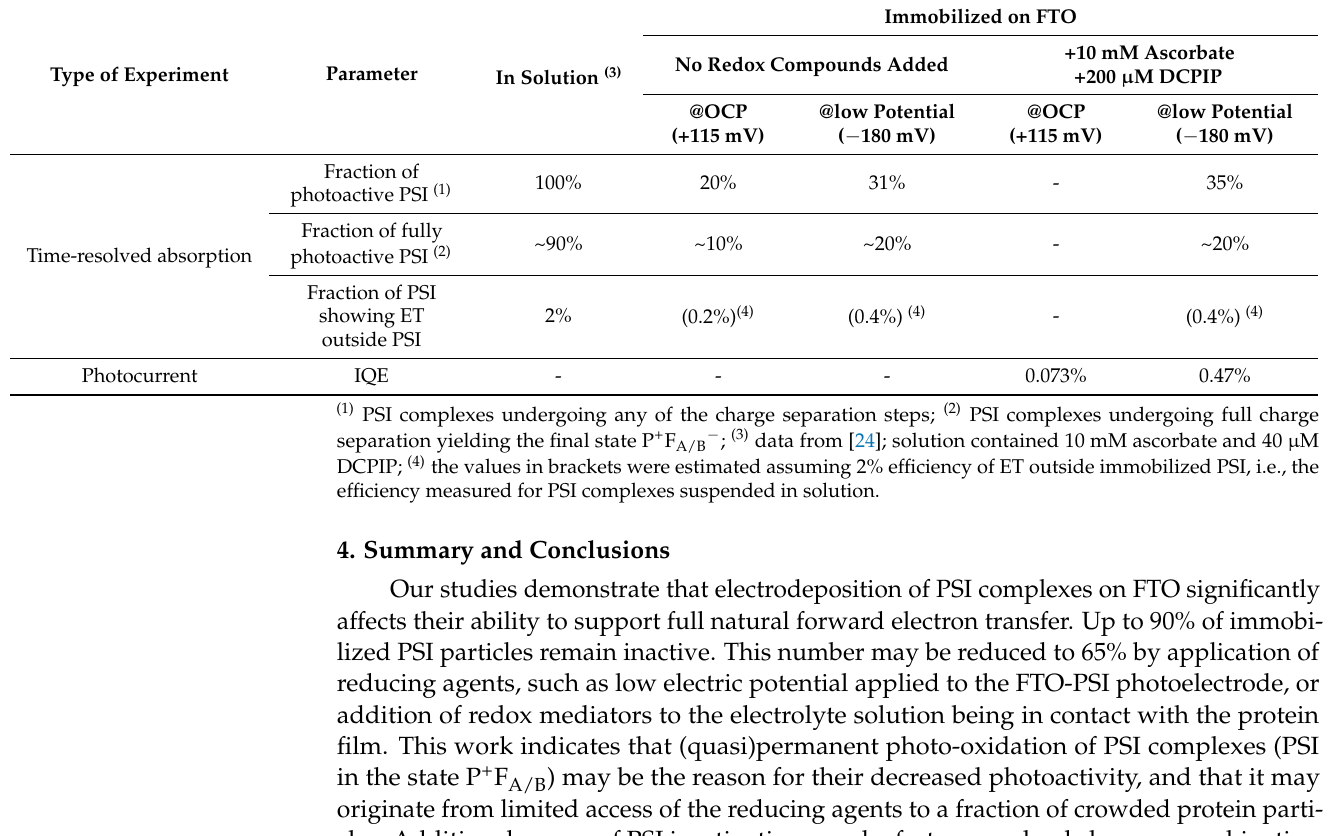
Table 2. Comparison of parameters related to charge separation in C. merolae PSI, ET outside PSI, and IQE estimated from the time-resolved absorption or photocurrent